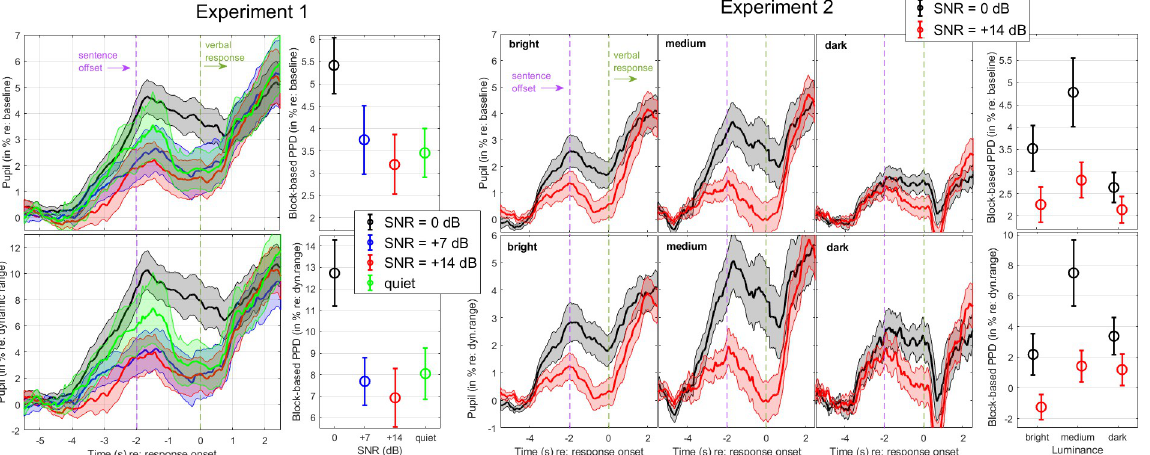
Fig 5. Averaged pupil traces and metrics. Averaged pupil traces and their respective block-averaged PPD amplitudes expressed as a proportional change from baseline (top) or as a proportional change relative to the dynamic range (bottom), in both experiments. In Exp.2, the dynamic range was much greater than in Exp.1 (as it was induced by luminance differences instead of subtle task differences such as SNR), resulting in a narrower scale of percentage changes. Error bar and shaded area represented 1 standard error from the mean.